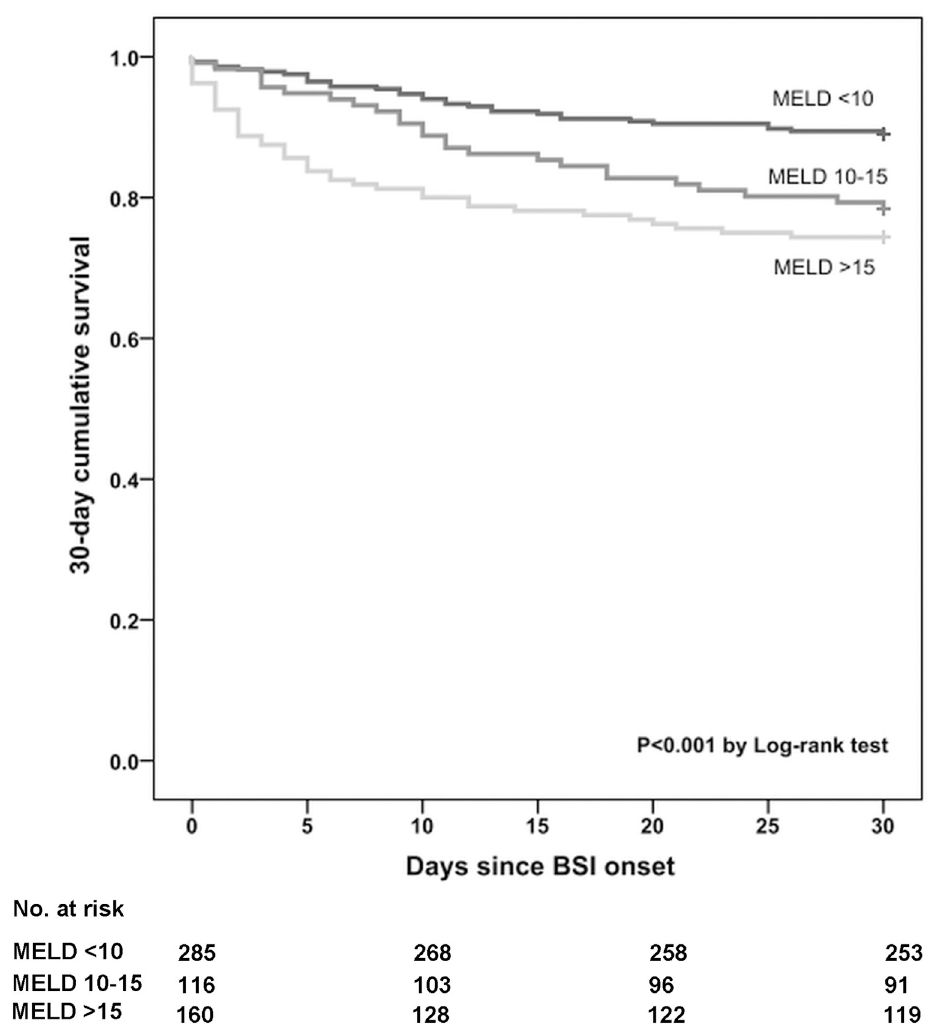
Fig 2. Survival Curvesin Patients with Staphylococcus aureus Bloodstream Infection and a MELD Score at Infection Onset of < 10, 10–15,or > 15 Points; Kaplan-Meier estimates. Abbreviations: BSI, bloodstream infection; MELD, Model for End-stageLiver